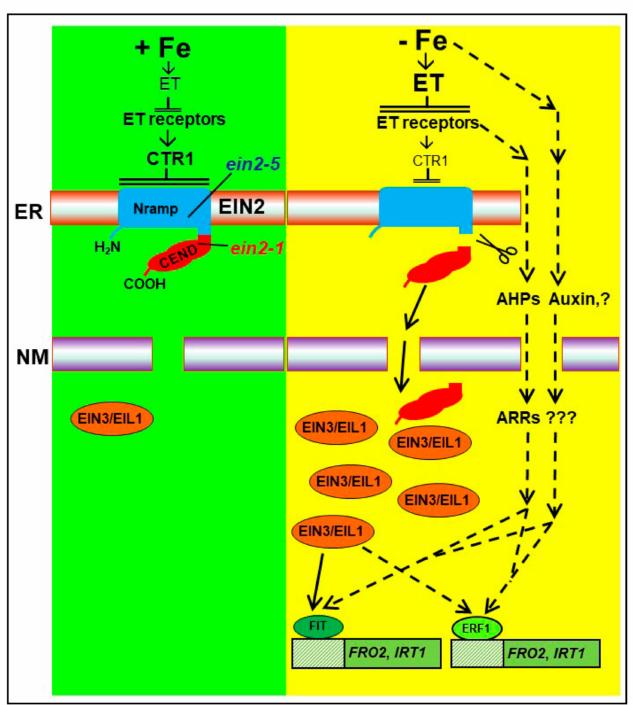
Figure 1. Model for the role of ethylene, through EIN2, on the upregulation of the Fe acquisition genes FRO2 and IRT1 in Arabidopsis. Fe deficiency causes enhanced ET production in roots. In the presence of ET, the CEND portion of the EIN2 protein is cleaved and shuttled into the nucleus where it increases the transcriptional activity of the EIN3/EIL1 TFs (see Introduction for more details). The accumulation of these latter TFs trigger ET responses, such as enhanced FIT transcription and, consequently, FRO2 and IRT1 upregulation. The transcription of FIT , FRO2 and IRT1 could also be triggered through alternate pathways, such as the “non canonical” ET-signaling route involving AHPs and ARRs or the ones involving other hormones, such as auxin (dashed lines). In addition to FIT , the different routes could also upregulate FRO2 and IRT1 through other TFs, such as ERF1. Abbreviations: AHPs, Arabidopsis Histidine-containing Phosphotransmitters; ARRs, Arabidopsis Response Regulators; ER, Endoplasmic Reticulum; ERF1, Ethylene Response Factor1; ET,